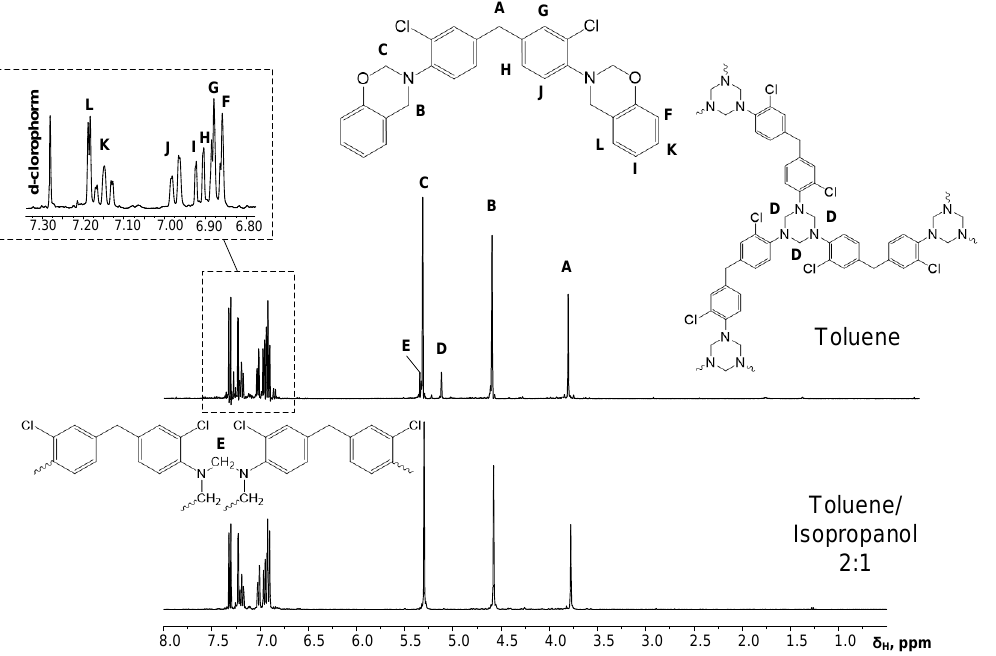
Figure 2. Synthesis of benzoxazine monomers based on diamines.